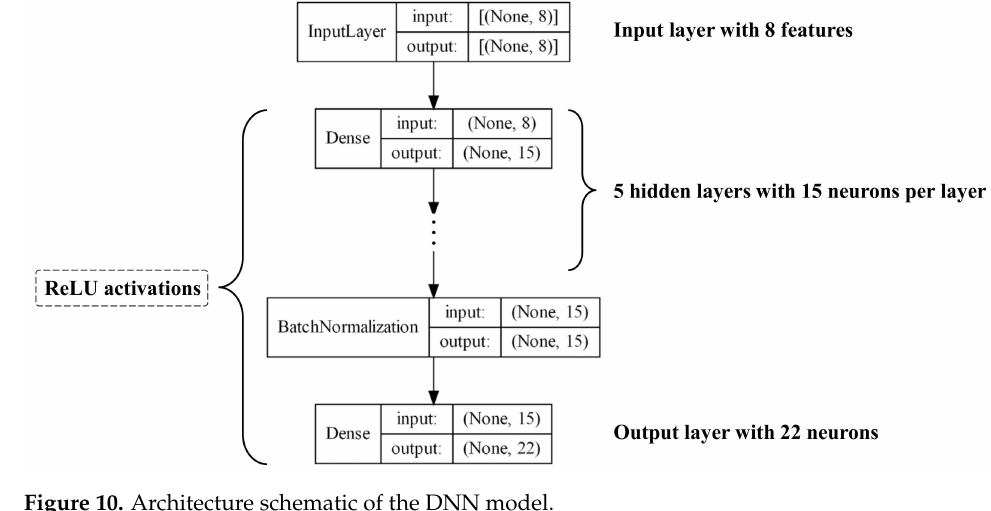
Figure 10. Architecture schematic of the DNN model.